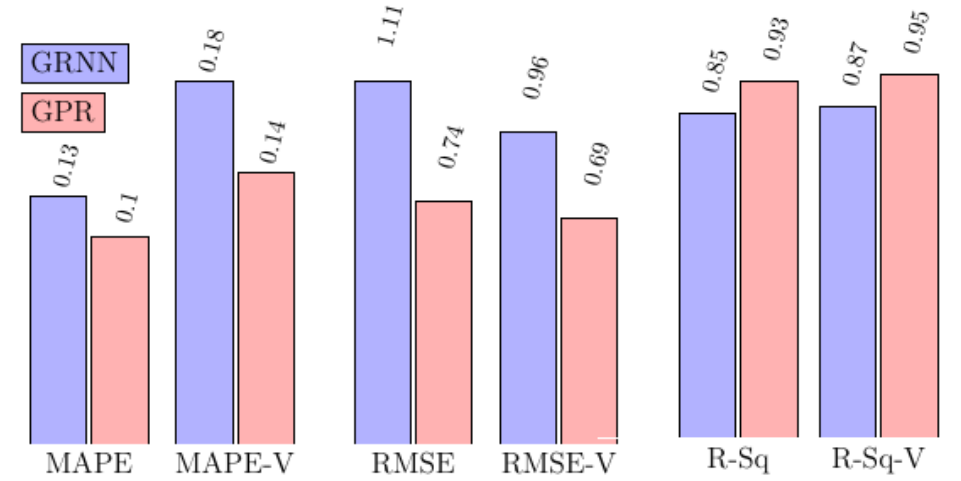
Figure 19. Comparison histogram of model characteristics for Ra.